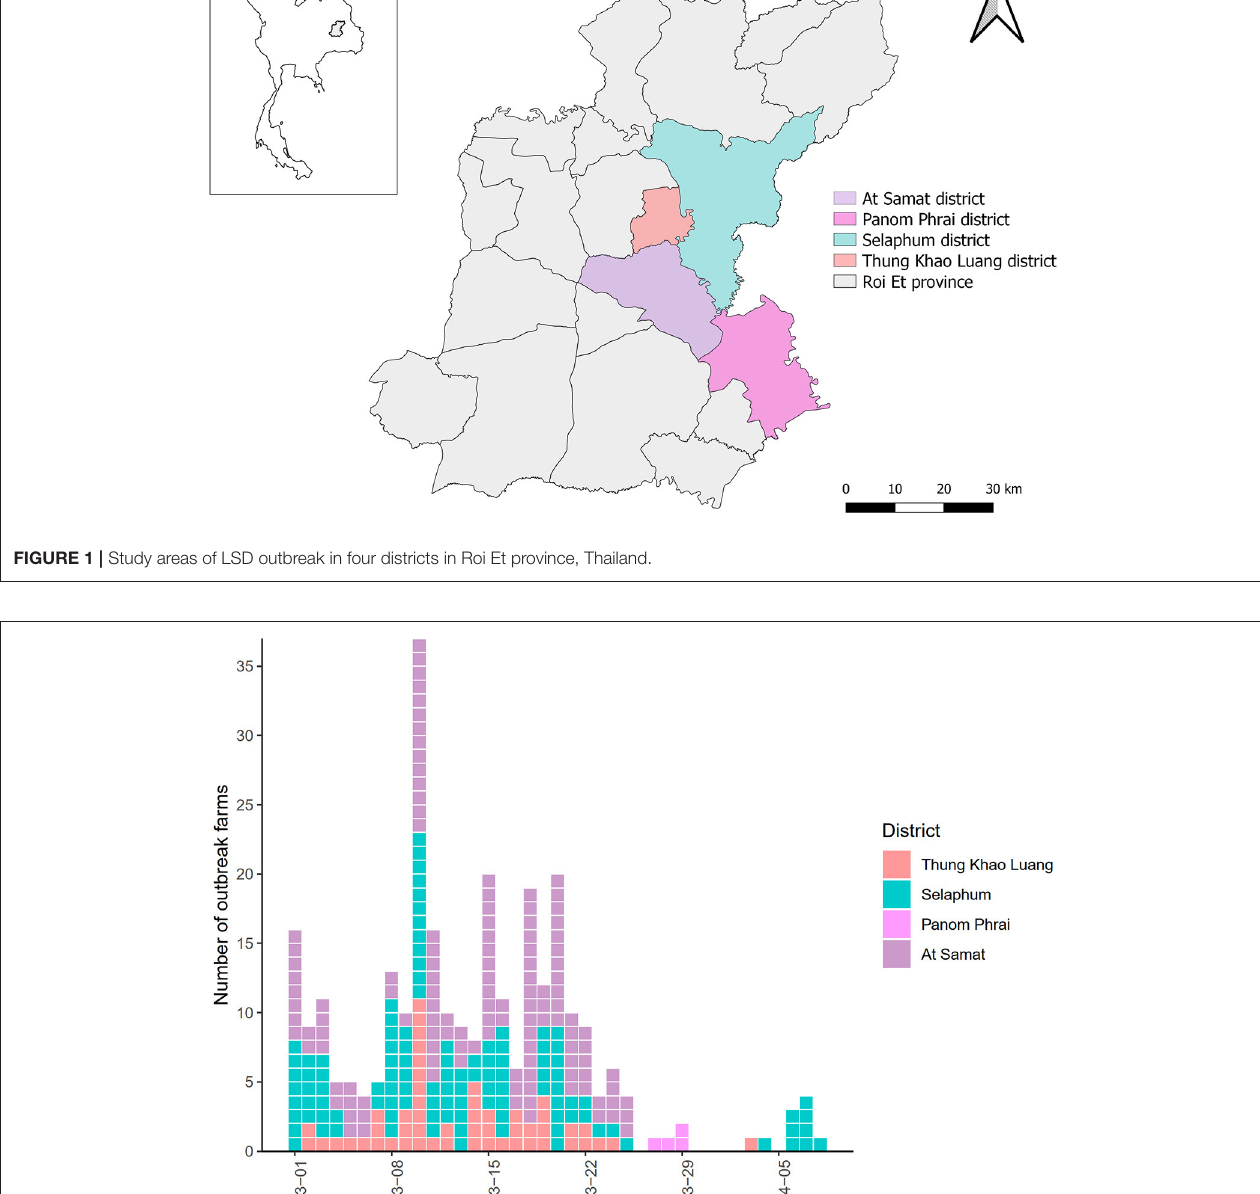
Frontiers in Veterinary Science |